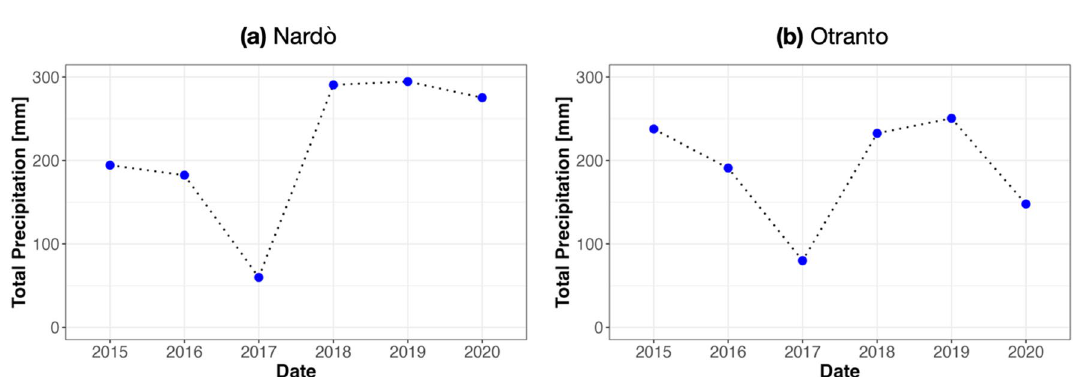
Figure 1. Total monthly precipitation (Meteo-data were collected from the Nardò meteo-station close to the fields Nardò A, Nardò B as well as Galatone, and from the Otranto one which is close to Cannole) (mm) between March to August from 2015 to 2020 for ( a ) Nardò meteorological station—Ionian Coast and ( b ) Otranto meteorological station-Adriatic coast.